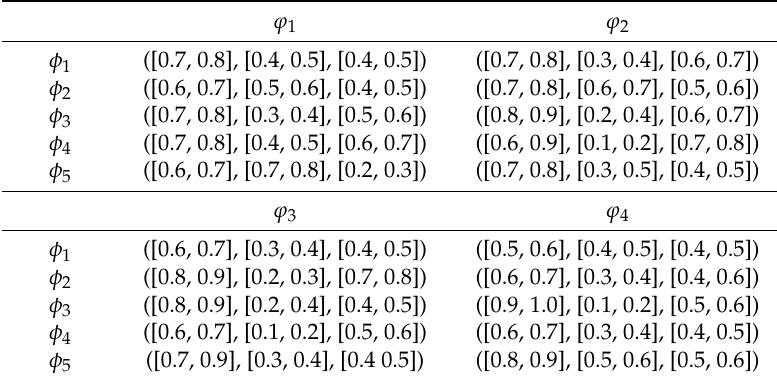
Table 3. The decision matrix (cid:101) R 3